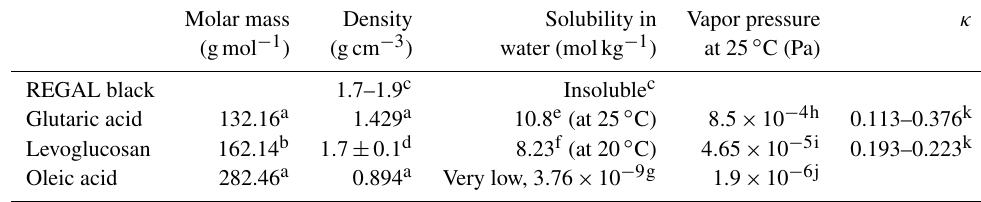
Table 1. Thermodynamic properties of components used in this study.